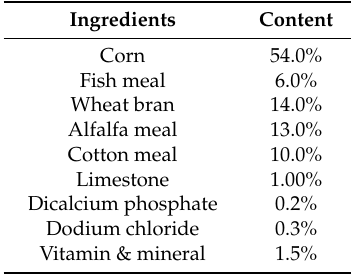
Table 1. Composition of the basal diets.